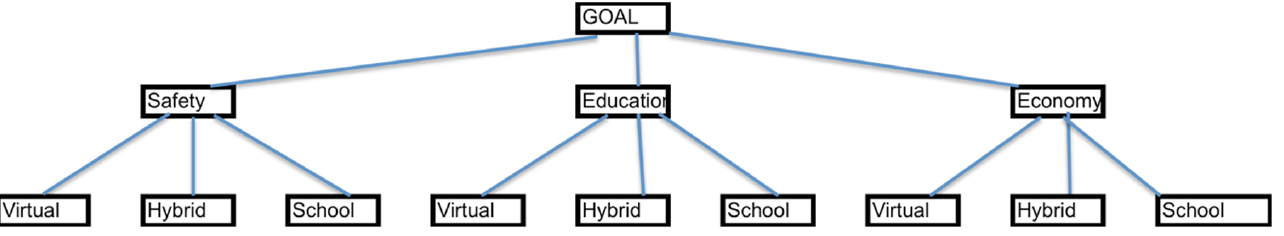
Figure 1. AHP tree for the Direct Comparison Model (DCM) example.